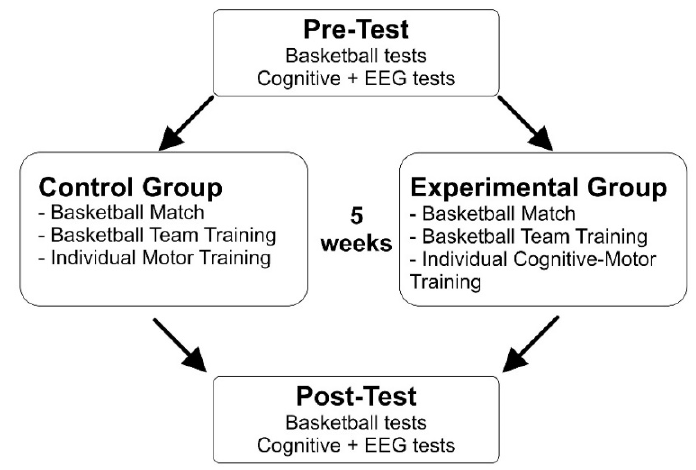
Figure 1. Representation of the experimental procedure.